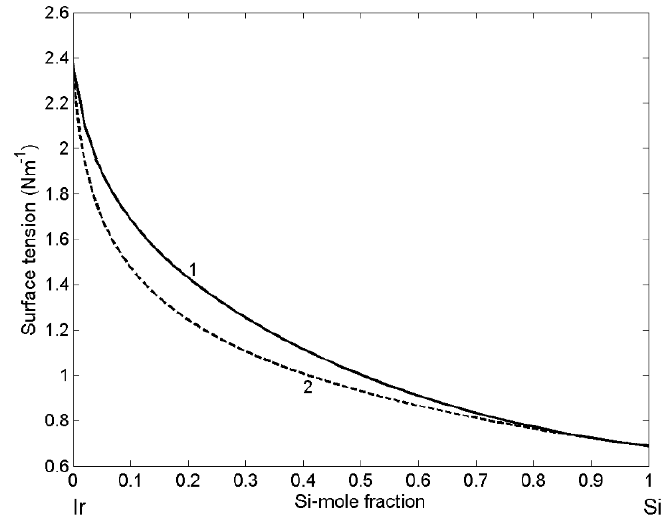
Figure 6. Surface tension isotherm of liquid Ir-Si alloys calculated for T = 1873 K by the QCA for regular solutions. (- - - - - -) the perfect solution model.